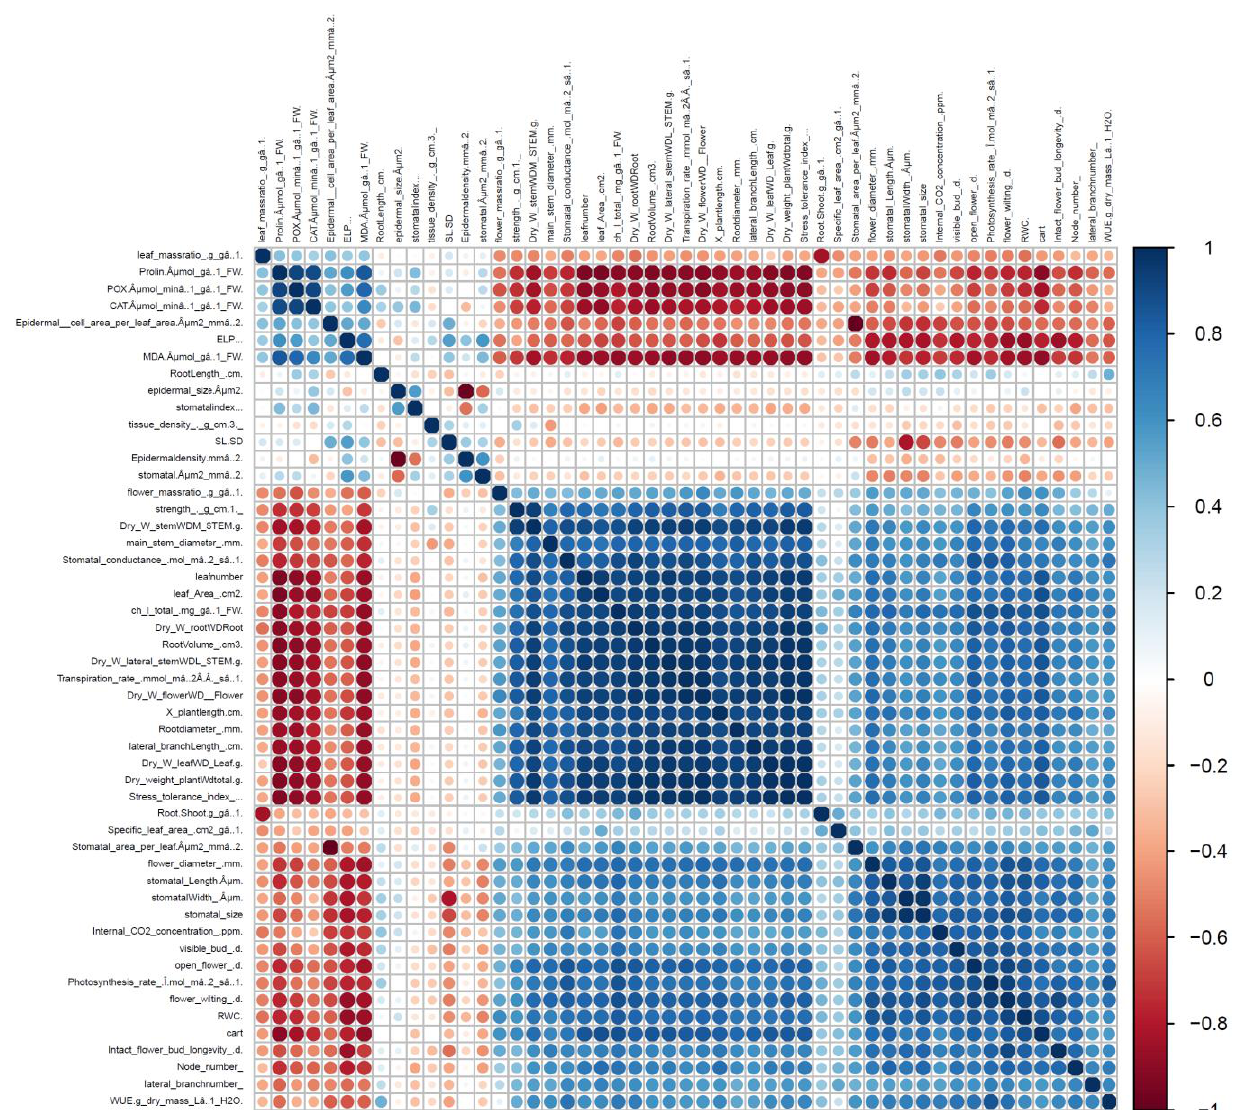
Figure 1. Positive, neutral and negative affinities across morpho-physiological traits in periwinkle ‘Pacifica XP Really Red’ . Plants received exogenous application of titanium dioxide nanoparticles (0, 0.5 and 1 mM), sodium hydrosulfide (0.5 and 1 mM), or salicylic acid (1 and 2 mM) under different watering levels (80, 50 and 20% available water content) during cultivation. Positive correlations are portrayed by blue circles, while negative associations are indicated by red circles. The intensity of color corresponds to the correlation coefficient (r) ranging from − 1 to 1 (scale). The larger size of circles indicates statistically significant values (non-significant, p = 0.05, p = 0.01, p = 0.001, respectively).